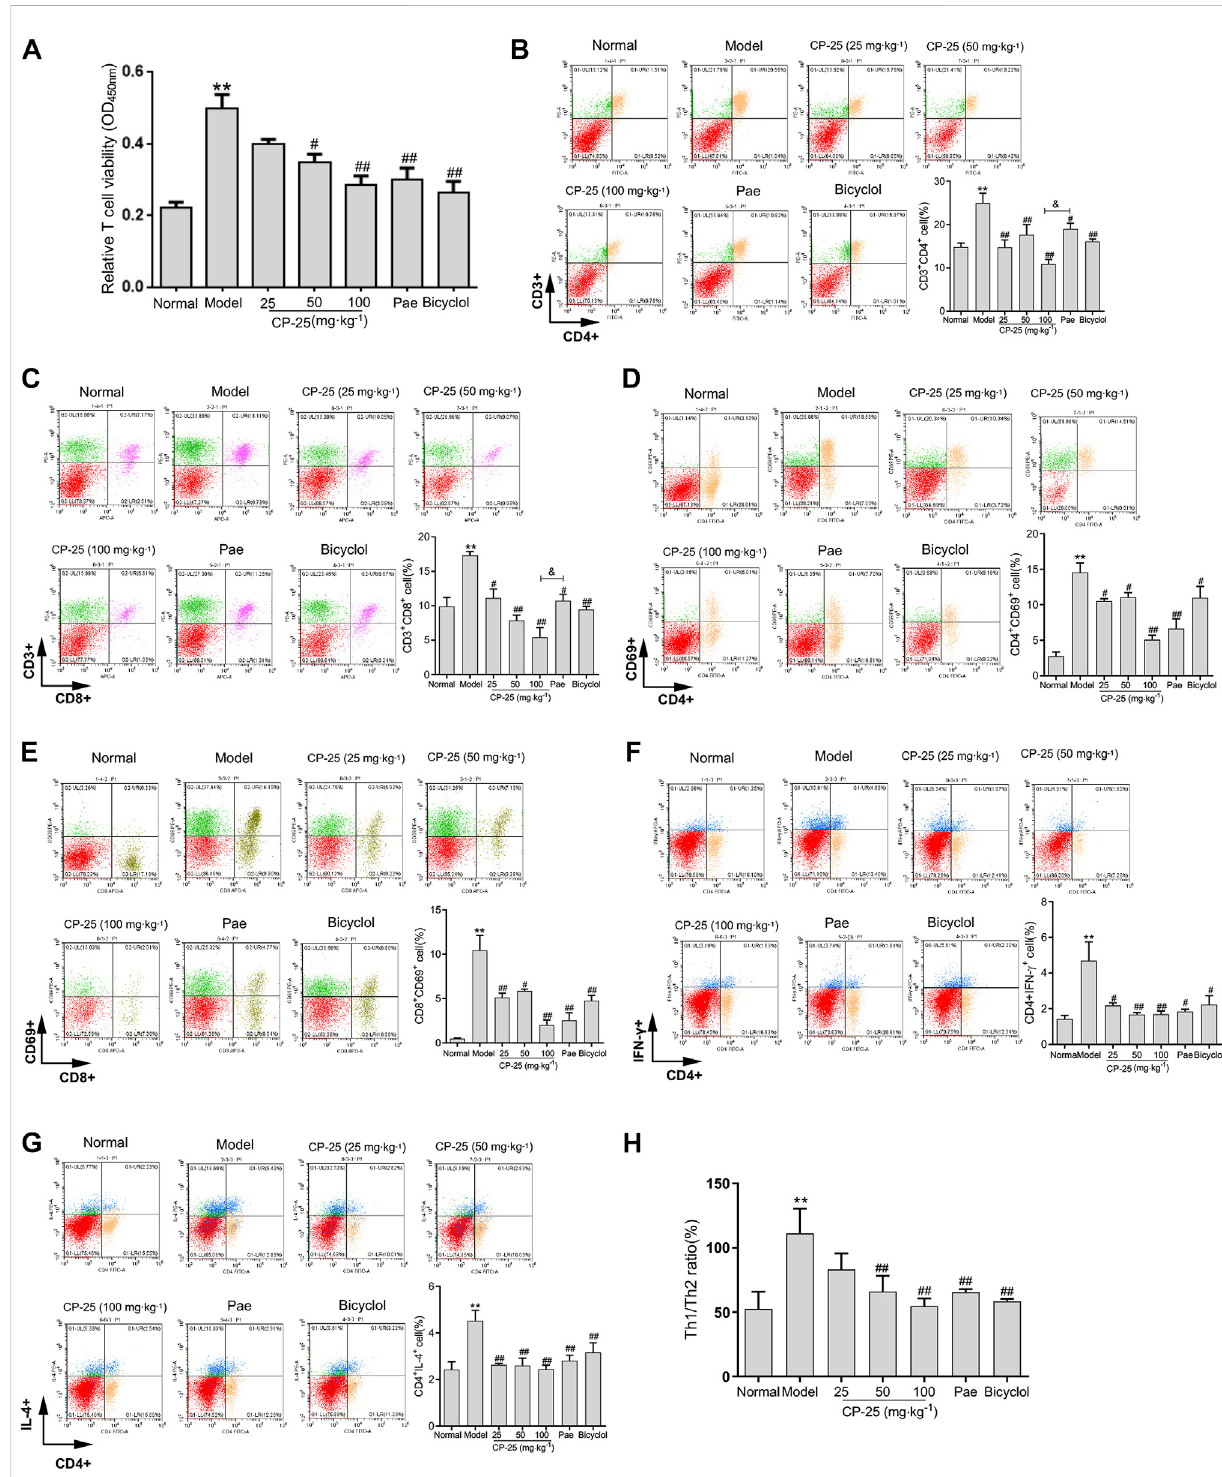
FIGURE 2 CP-25amelioratedTcellsactivationinhepatitis. (A) TheCCK-8absorbancevaluesofTcellsfrommicethymus.Flowcytometryanalysisofsingle- cellsuspensions ofliveimmunocytes,which wereisolatedfromfreshlydissociatedspleenofmiceinjectedwithConA. Therepresentativepictures and bargraphsshowedthepercentagesofCD3 + CD4 + Tcell (B) ,CD3 + CD8 + Tcell (C) ,activatedCD4 + Tcell (D) ,activatedCD8 + Tcell (E) ,Th1 (F) andTh2 (G) cells. And theratio of Th1/Th2 on each group (H) . Data of each marker were expressedas the mean ± SD at least three independent experiments. **p < 0.01 versus normal, # p < 0.05, ## p < 0.01 versus model, & p < 0.05 versus paeoni fl